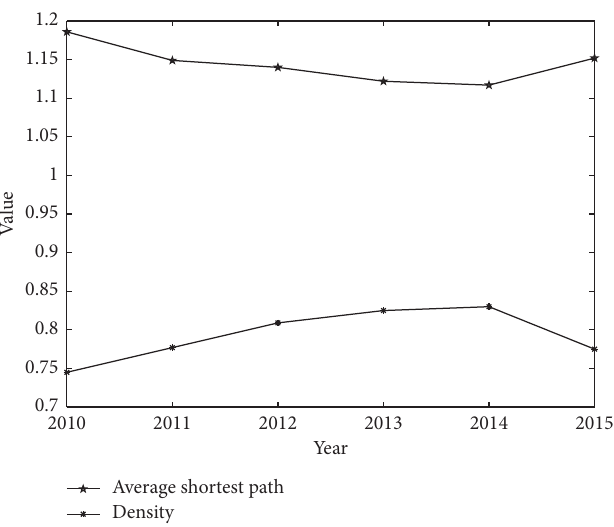
Figure 2: Coverage and tightness of the interprovincial population mobility network. Table 1: The top 5 provinces for population inflow diversity in